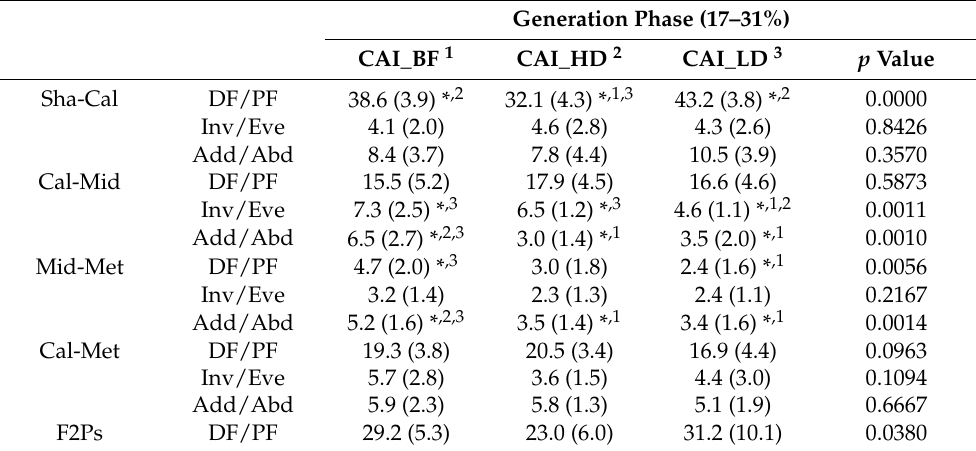
Table 5. Summary of mean RoM and standard deviation (in degrees) during generation phase in CAI_BF versus CAI_HD versus CAI_LD.